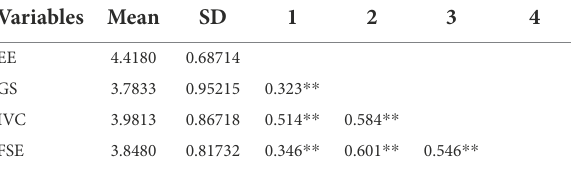
TABLE 3 Descriptive statistics and correlations analyses.